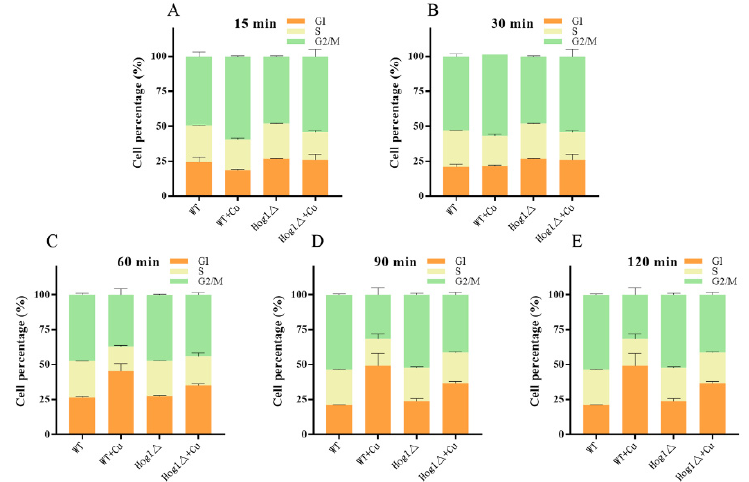
Figure 7. The proportion of log-phase cells (WT and Hog1 ∆ ) in the G1, S, or G2/M phases of the cell cycle based on flow cytometric analysis grown in YPD with 4 mM CuSO 4 . DNA content was measured at the indicated time points ( A ) 15 min, ( B ) 30 min, ( C ) 60 min, ( D ) 90 min, and ( E ) 120 min. The error bars represent standard deviations, and 50,000 events were acquired in each analysis.